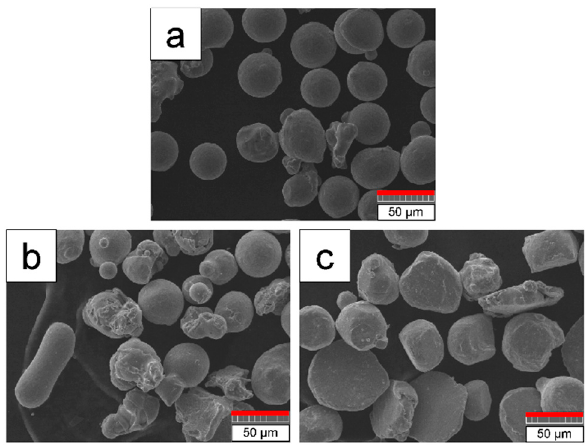
Figure 3. SEM images of Co powders after HEMT operation. ( a ) t = 0 min, ( b ) t = 1 min, ( c ) t = 2 min.